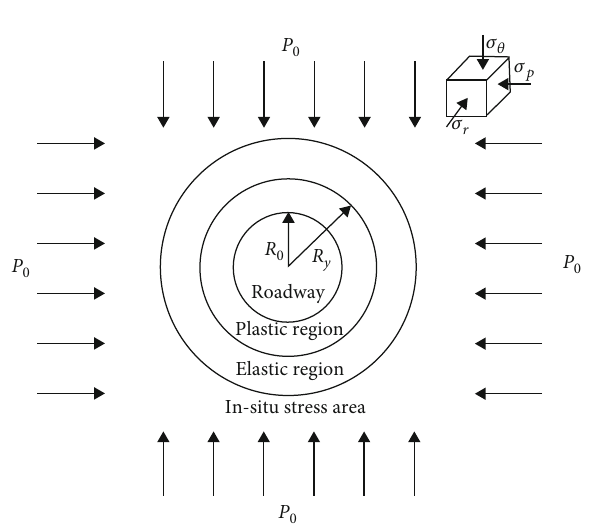
Figure 1: Composite strata histogram.